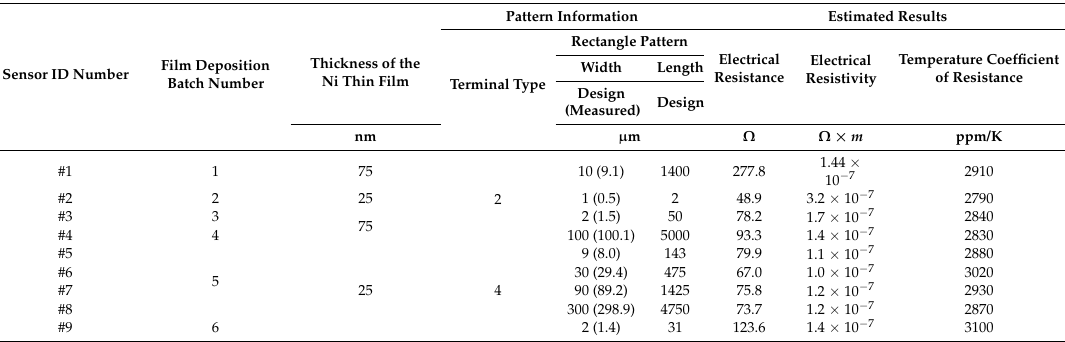
Table 1. List of the sensor design parameters and